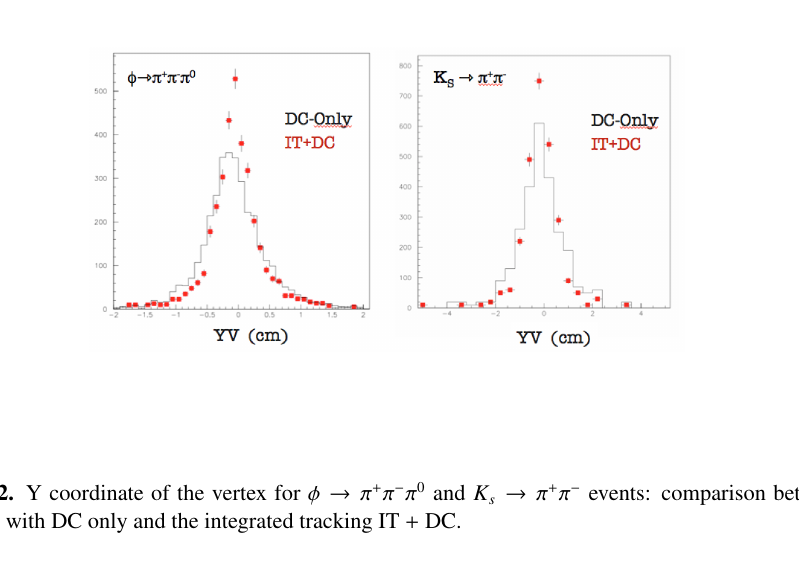
Figure 2. Y coordinate of the vertex for φ → π + π − π 0 and K s → π + π − events: comparison between tracking with DC only and the integrated tracking IT +